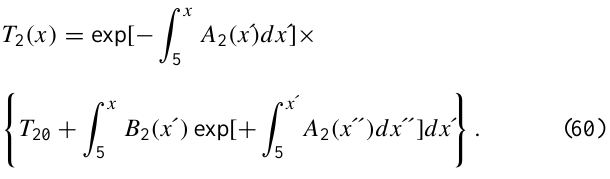
Fig. 4. Shown versus solar distance r along the upwind axis is the temperature T 2 of secondary solar wind ions in units of [Mega Kelvin] for various solar wind bulk speeds V w . Consistent with the variation of V w , solar wind density, the Alfv´en speed and the en- ergy input parameters g 0 and G 0 have also been changed according to prescriptions derived in the